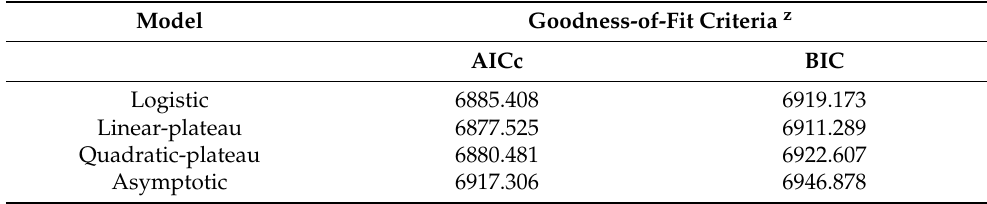
Table 1. Goodness-of-Fit criteria for mixed nonlinear asymptotic models describing temporal produc- tion of floral hemp threshed